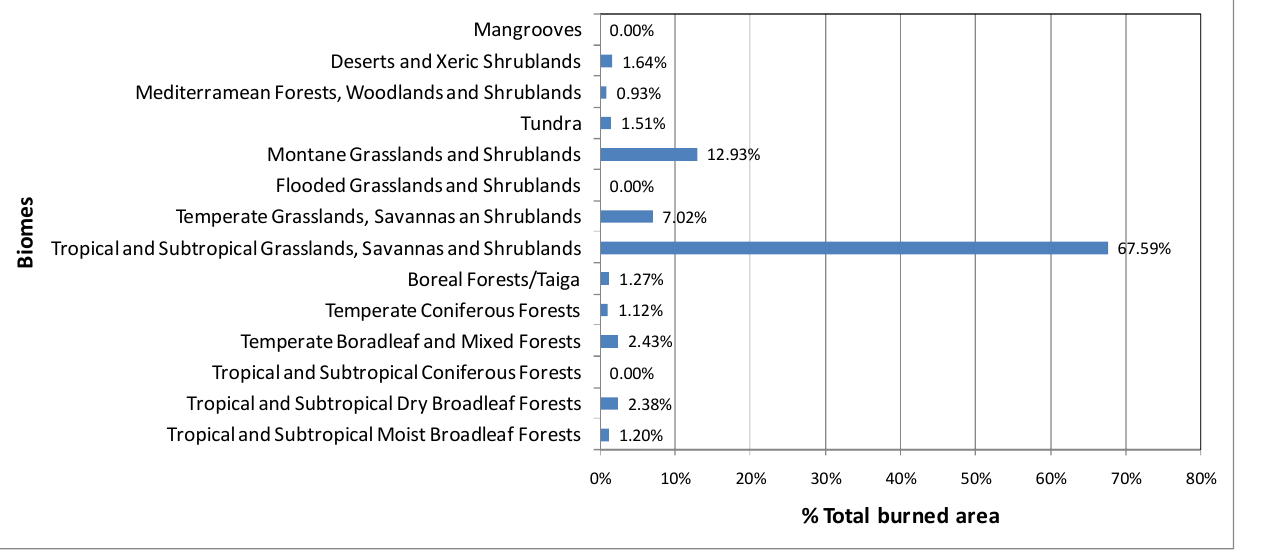
Figure 9. Total burned area per biome in percentages estimated after overlaying the sampling scenes with MODIS fire perimeters.